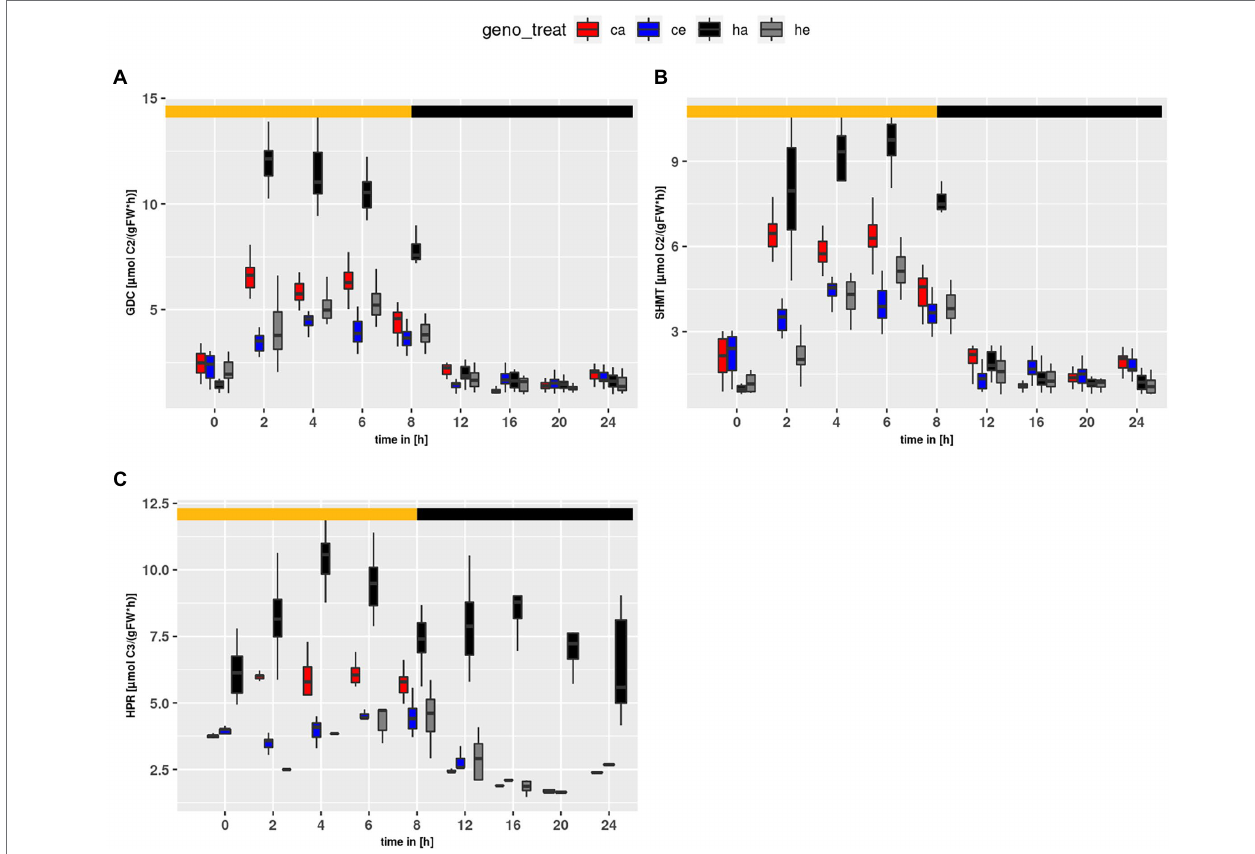
FIGURE 6 | Diurnal course of fluxes for (A) GDC , (B) SHMT and (C) HPR . Col-0 ambient: red, Col-0 eCO 2 : blue; hpr1-1 mutant ambient: black, hpr1-1 mutant eCO 2 : grey. Shown are means of results for 20 simulations. Light phase is indicated by yellow bar and dark phase indicated by black bar. Boxplots are dodged by 0.25 h in order to prevent